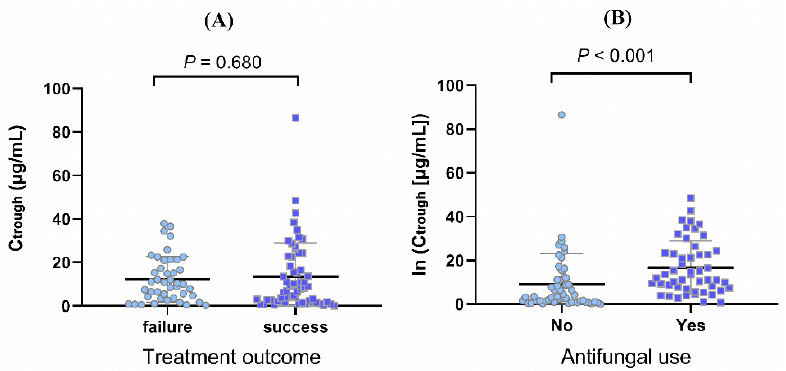
Figure 1. Distinction of meropenem trough concentrations in different groups ( n = 101); ( A ) treatment outcome and ( B ) concomitant antifungal use.